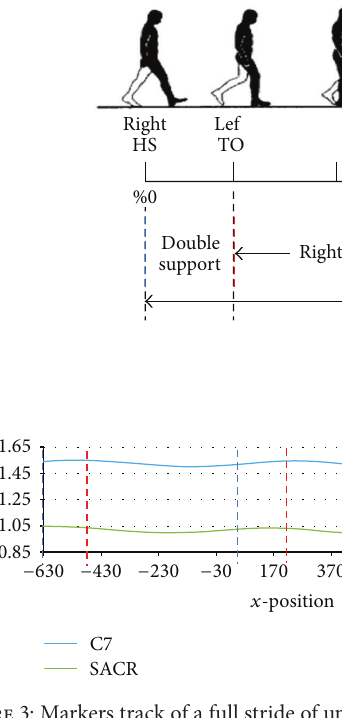
Figure 3: Markers track of a full stride of upper body of a practical human walk.